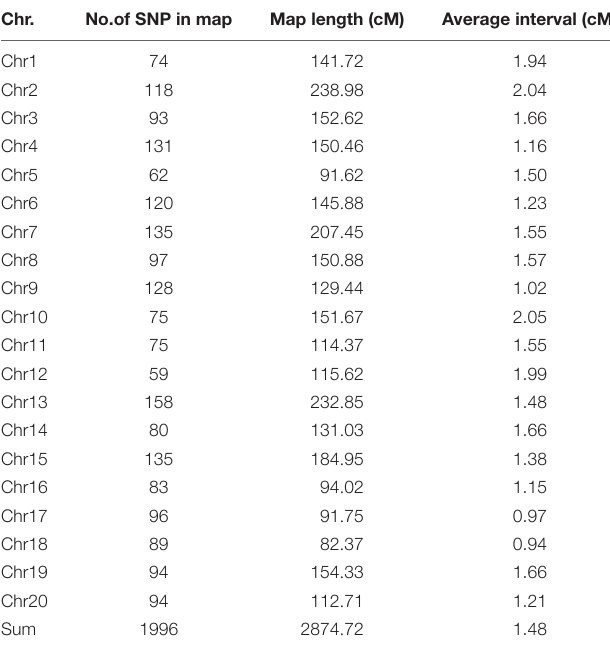
TABLE 3 | Description of characteristics of the 20 linkage groups in the high-density map.